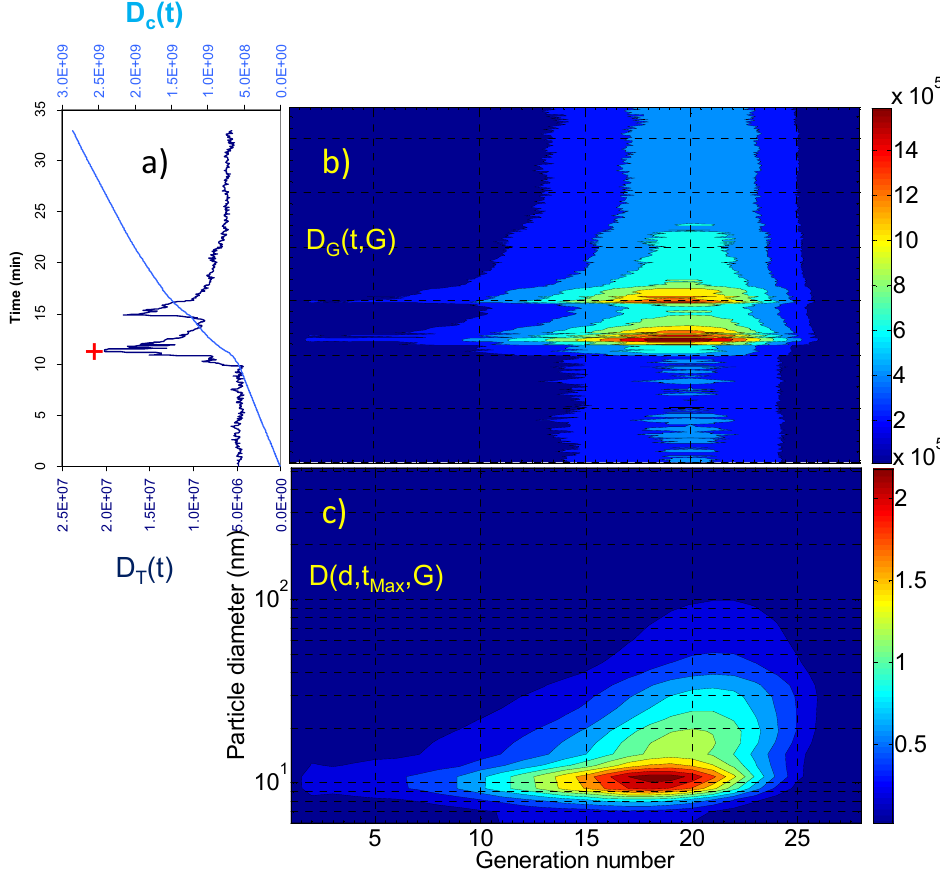
Figure 5. Living room, vacuum cleaning: ( a ) total instant dose D T (t) and cumulative dose D c (t) as a function of time; ( b ) instant dose per airway generation D G (t,G) as a function of time and airway generation number; ( c ) maximum instant dose D(d,t Max ,G) at the maximum D T (t) value (the red cross in (a)) as a function of particle diameter and of airway generation